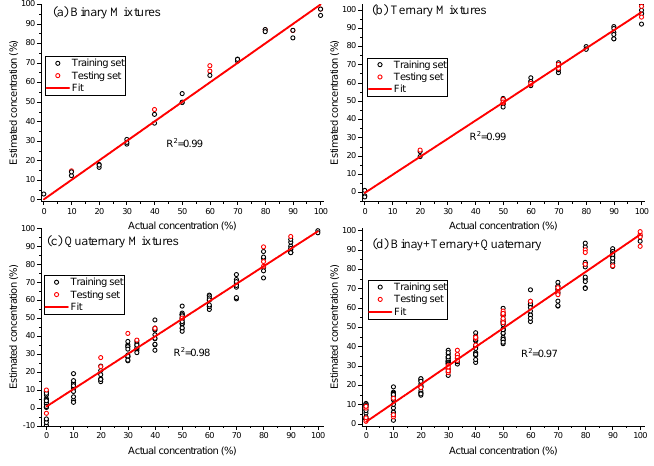
Figure 7. Actual concentration vs. estimated concentration of extra virgin olive oil (EVOO) calculated from binary, ternary, quaternary and combined (binary + ternary + quaternary) dataset using partial least squares (PLS) analysis. The solid line represents the zero-error